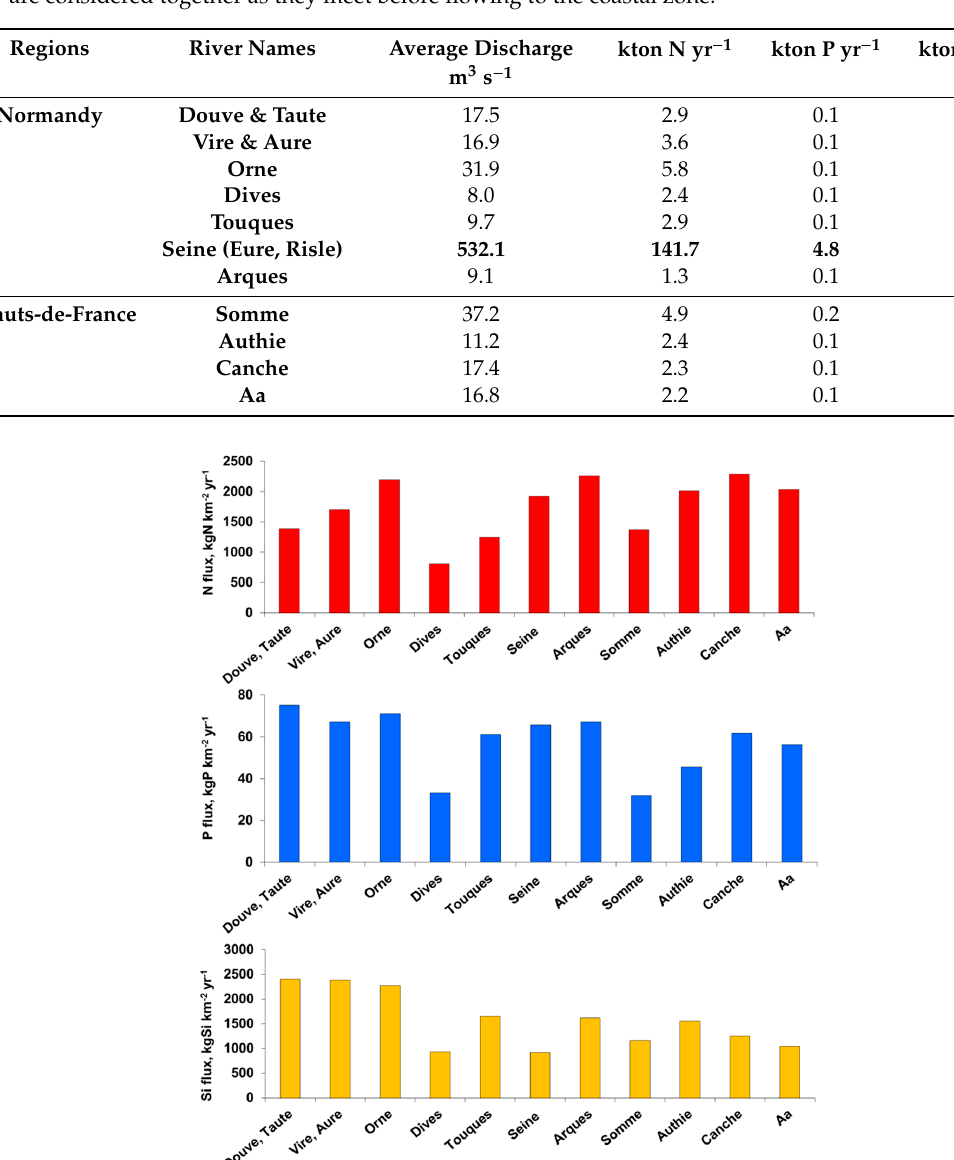
Figure 5. Indicator of coastal eutrophication potential for N and P (N-ICEP-N and P-ICEP; kg C km − 2 y − 1 ) for the rivers studied and averaged for the 2002–2014 period.